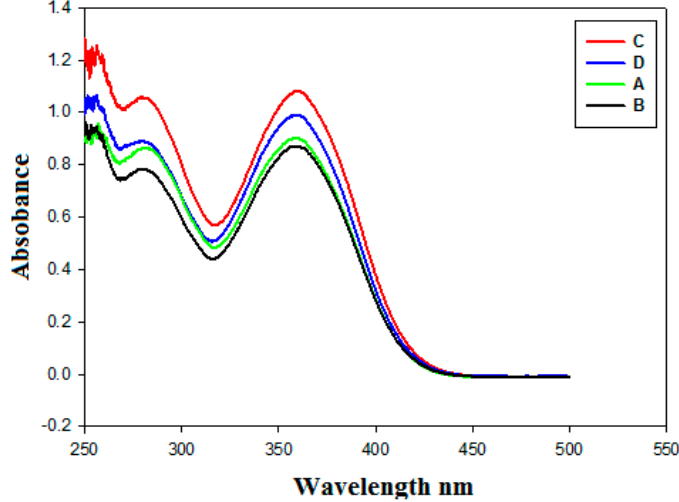
Figure 10. UV–vis spectra of compounds A – D in dichloromethane at 25 °C.